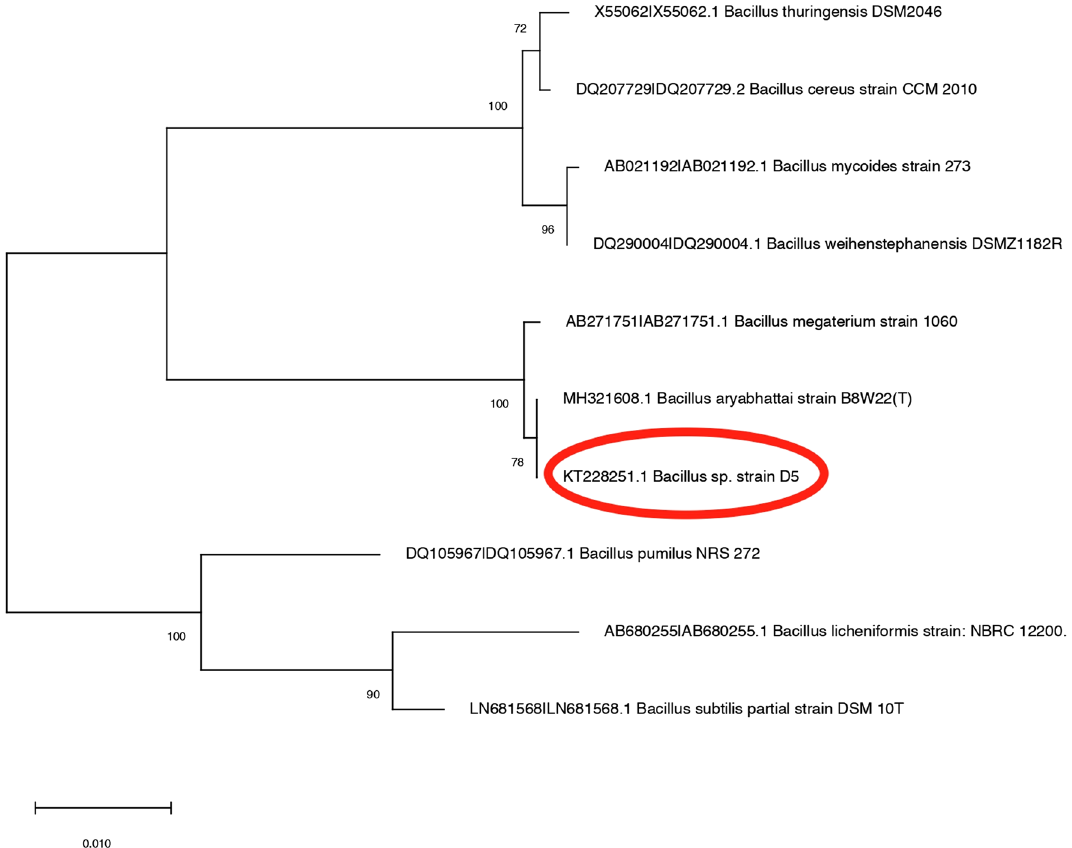
Figure 2. Evolutionary relationships of Bacillus sp. strain D5 with other known Bacillus type strains. The evolutionary tree was created using Neighbor-Joining method. The bootstrap concensus tree inferred from 1000 replicates. The evolutionary distances were computed using the Maximum Composite Likelihood method and are in the units of the number of base substitutions per site. Evolutionary analyses were conducted in MEGA X software.